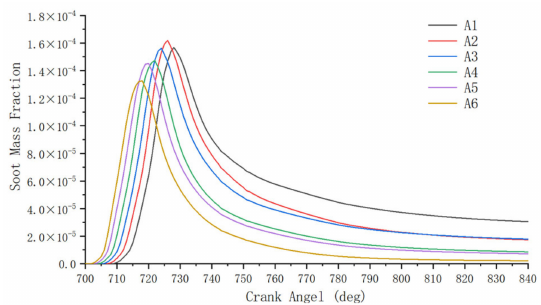
Figure 36. Soot distribution of the start of injection